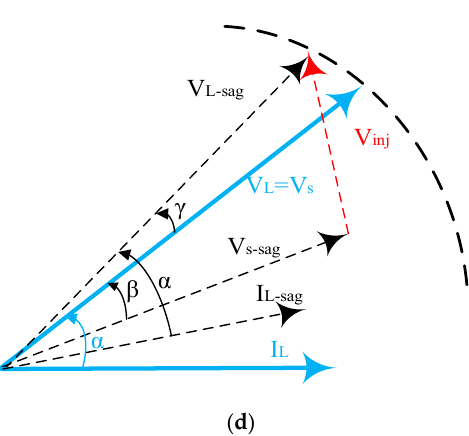
Figure11. Phasordiagramofvoltagecompensationmethods,( a )pre-sag,( b )in-phase,( c )energy-minimized Figure 11. Phasor diagram of voltage compensation methods, ( a ) pre-sag, ( b ) in-phase, ( c ) energy- (EM) for balanced sags, and ( d ) EM for imbalanced sags. Based on data from minimized (EM) for balanced sags, and ( d ) EM for imbalanced sags. Based on data from [129].